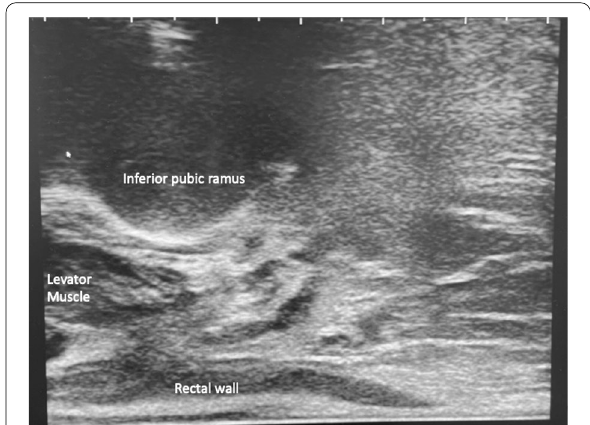
Fig. 8 Identification of a low-lying inferior pubic ramus allows for additional local anaesthetic administration to the associated musculotendinous structure